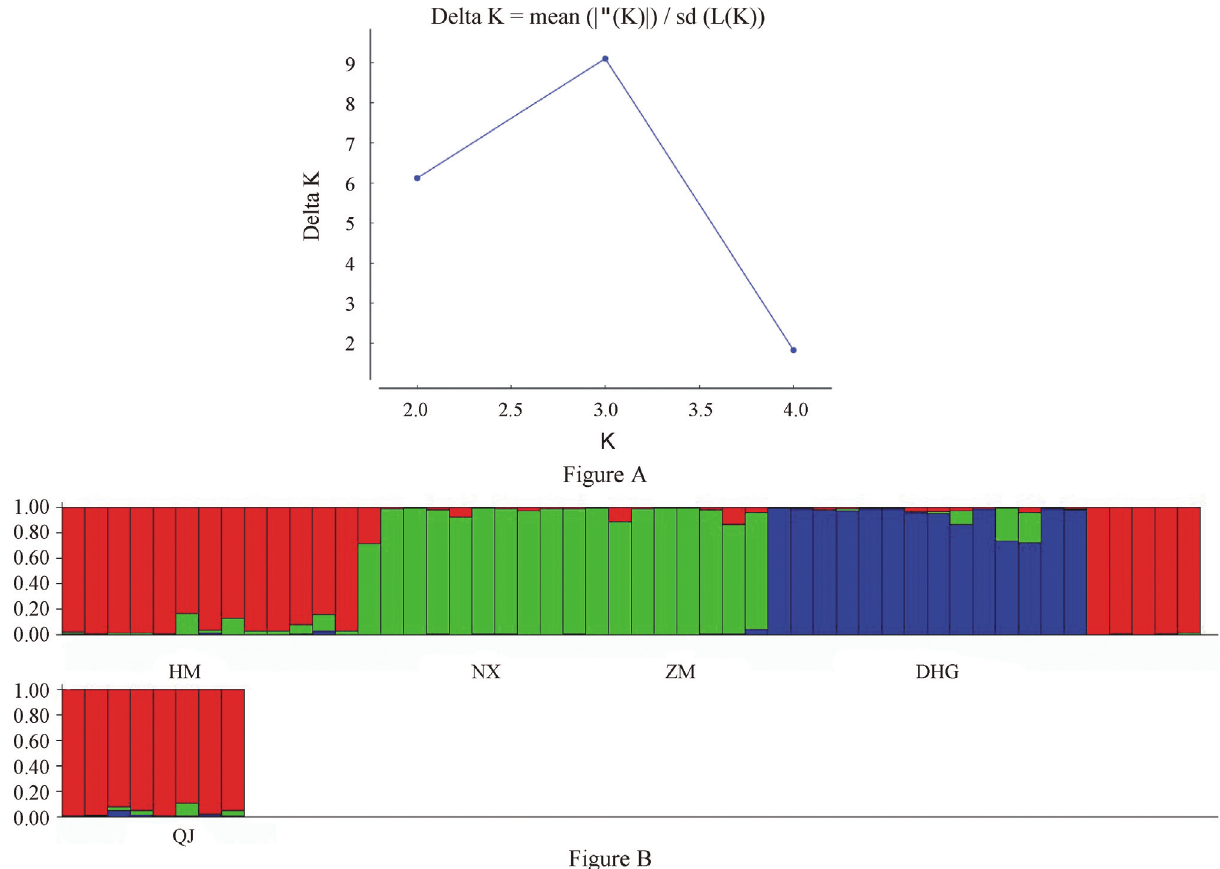
Figure 3 - Bayesian inference of the number of clusters ( K ) in R. tanguticum . (A) K was estimated from plots of ad hoc posterior probability models of (cid:5) K . (B) Bayesian admixture proportions ( q ) of individuals of cultivated R. tanguticum for K = 3. Each individual is represented by a single line broken into K colored segments, with lengths proportional to each of the K -inferred